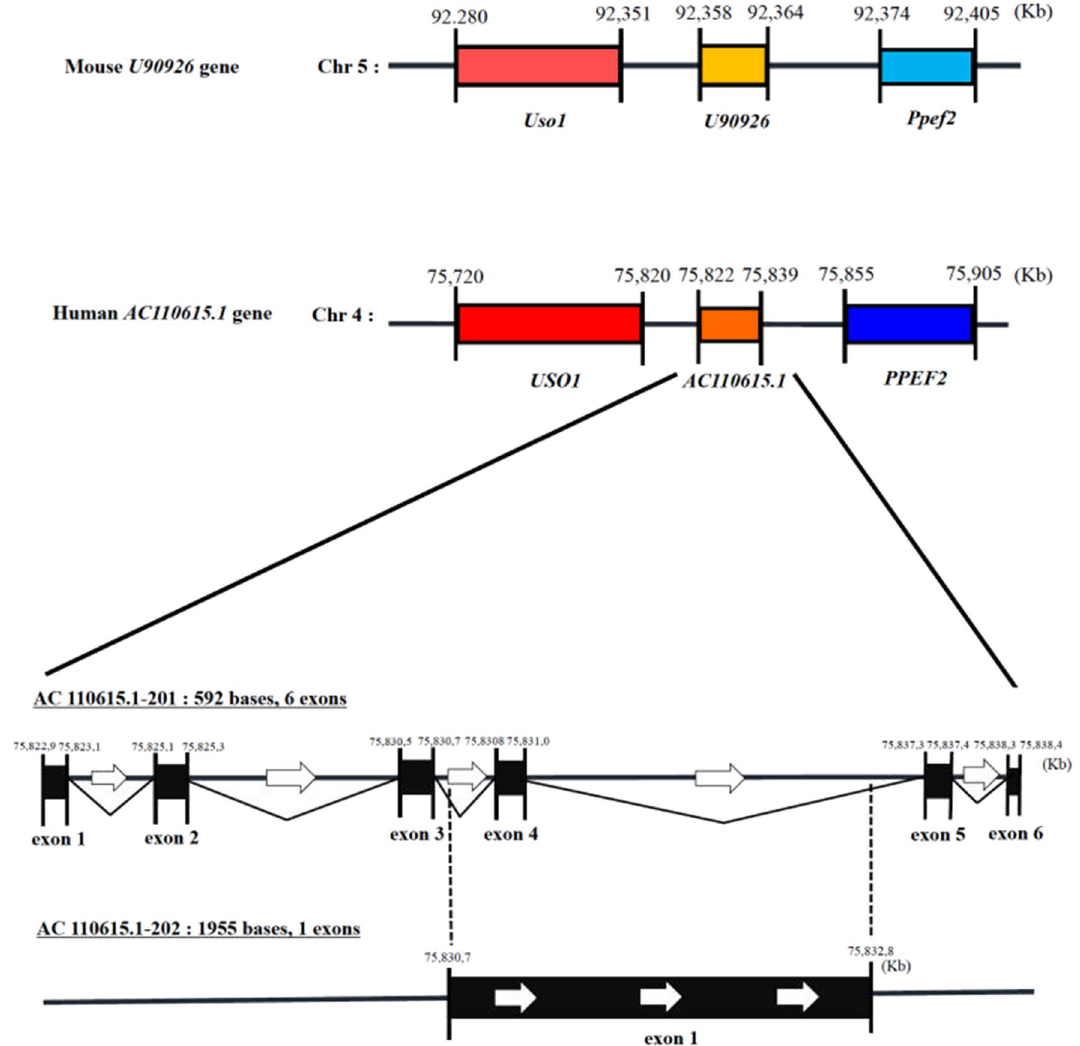
Figure 1. Human AC110615.1 transcribed from the region between USO1 and PPEF2 on chromosome 4. Schematic representation of the genomic organisation of the region containing mouse U90926 (GRCm38) (top) and human AC110615.1 (GRCh38) (middle), and that of the composition of human AC110615.1 transcript (GRCh38) containing AC110615.1-201 and AC110615.1-202